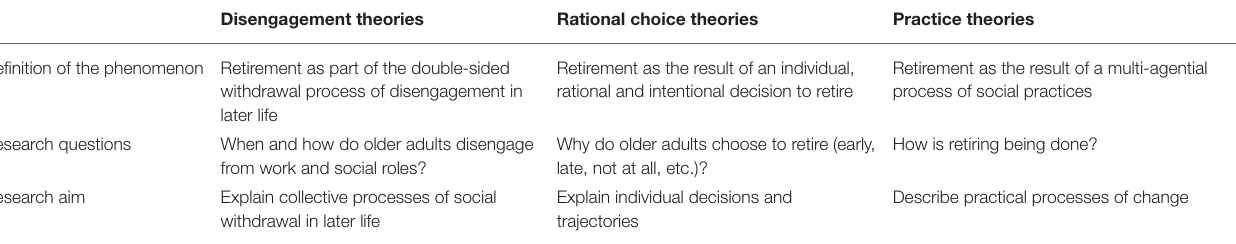
TABLE 1 | Comparison of disengagement theories, rational choice theories, and practice theories in regard to